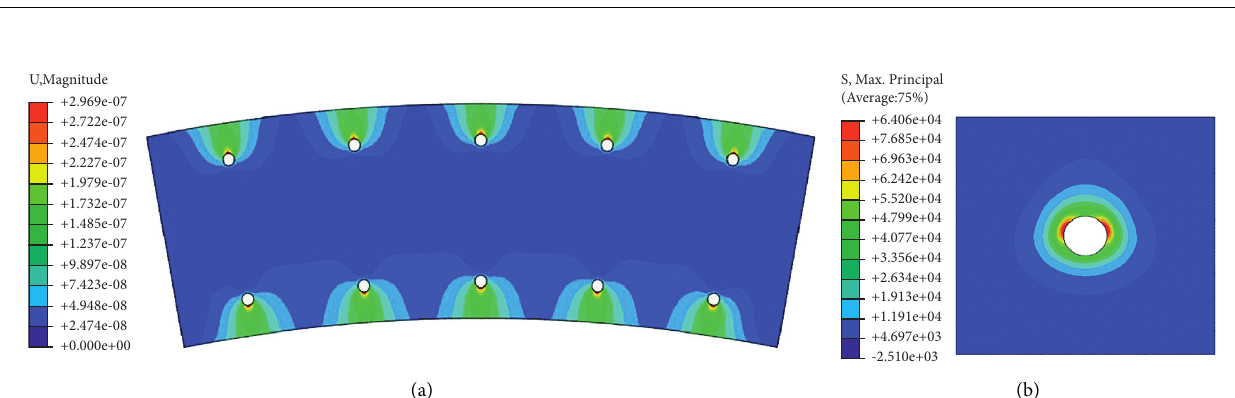
Figure 10: Degradation characteristics of the segment after 1 day of steel bar corrosion: (a) the displacement cloud during cracking and (b) the maximum principal stress cloud during cracking.